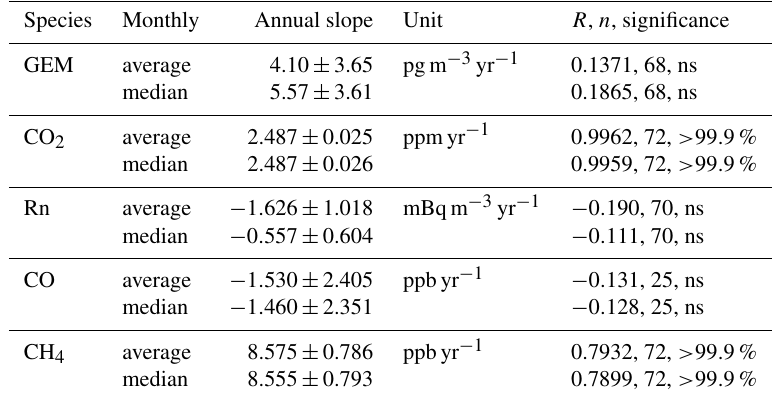
Table 2. Trends at Amsterdam Island for the 2012–2017 period. Calculated by LSQF from monthly averages and medians.